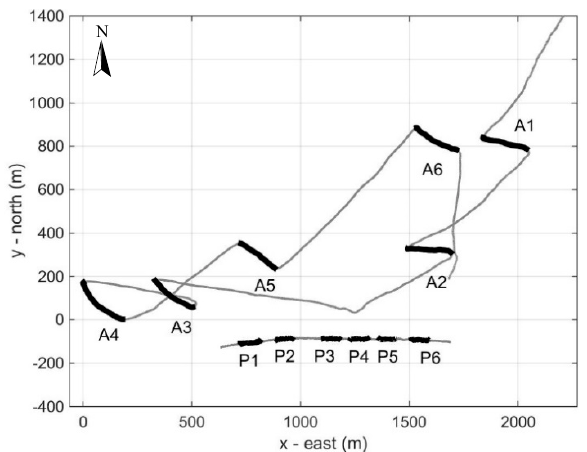
Figure 6. Vessel and buoy/pinger track during the shallow-water experiment in the Bay of Heraklion. The area corresponds to the rectangle shown in Figure 1. The drifting vessel positions during stations A1–A6 and corresponding buoy/pinger locations (P1–P6) are marked by heavy lines. Remote Sens. 2018 , 10 , x FOR PEER REVIEW